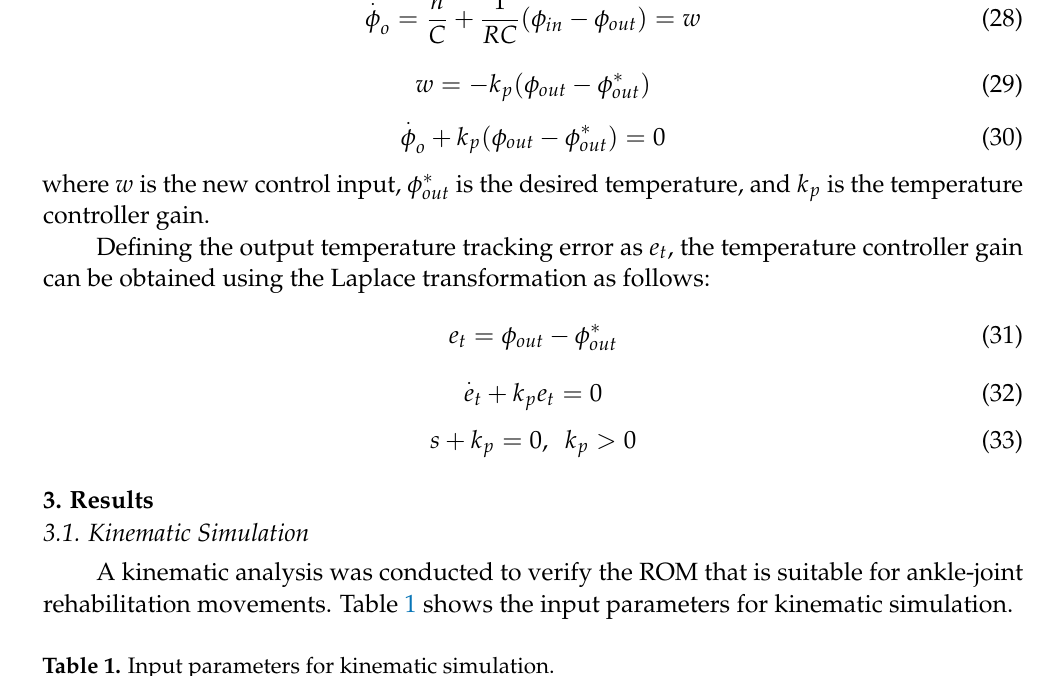
Table 1. Input parameters for kinematic